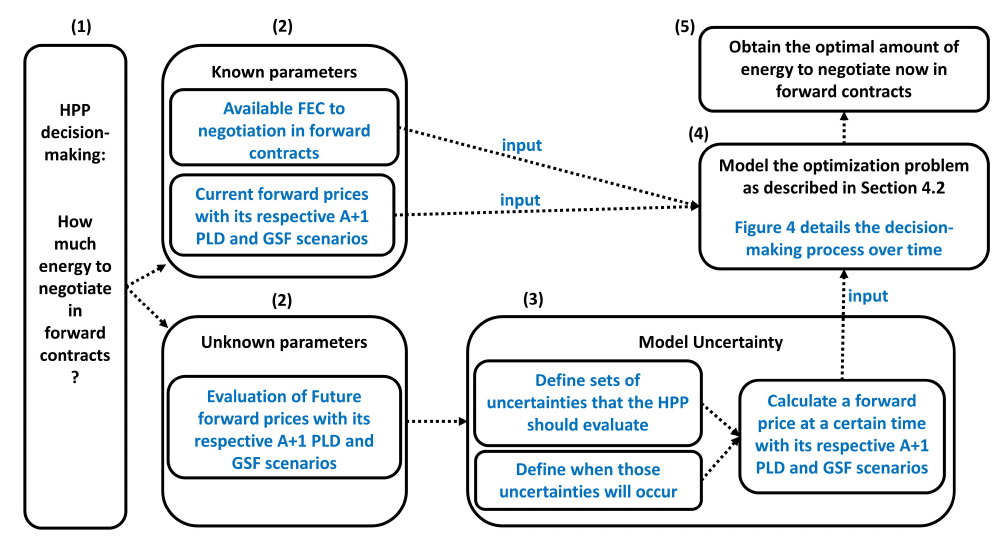
Figure 3. Proposed decision-making methodology flow chart.